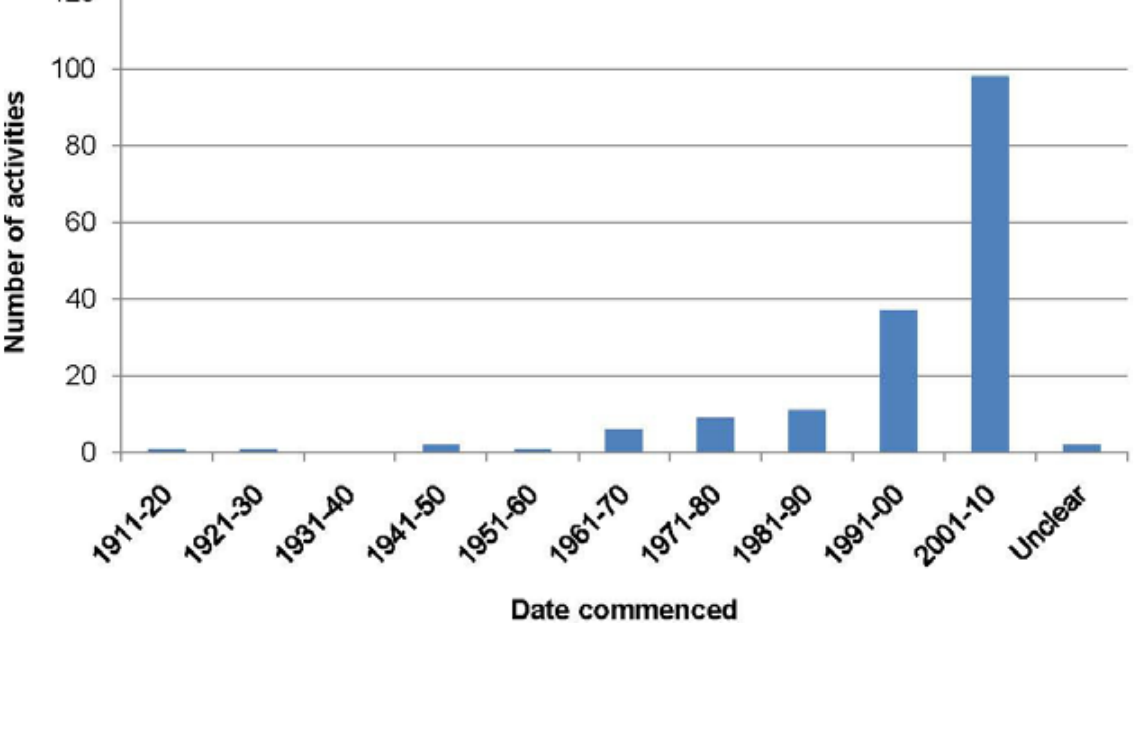
Figure 8: Date that activities